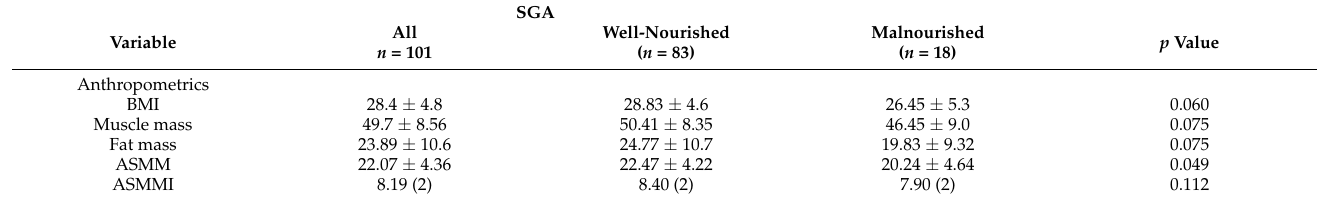
Table 2. Anthropometric characteristics of patients with T2DM according to the